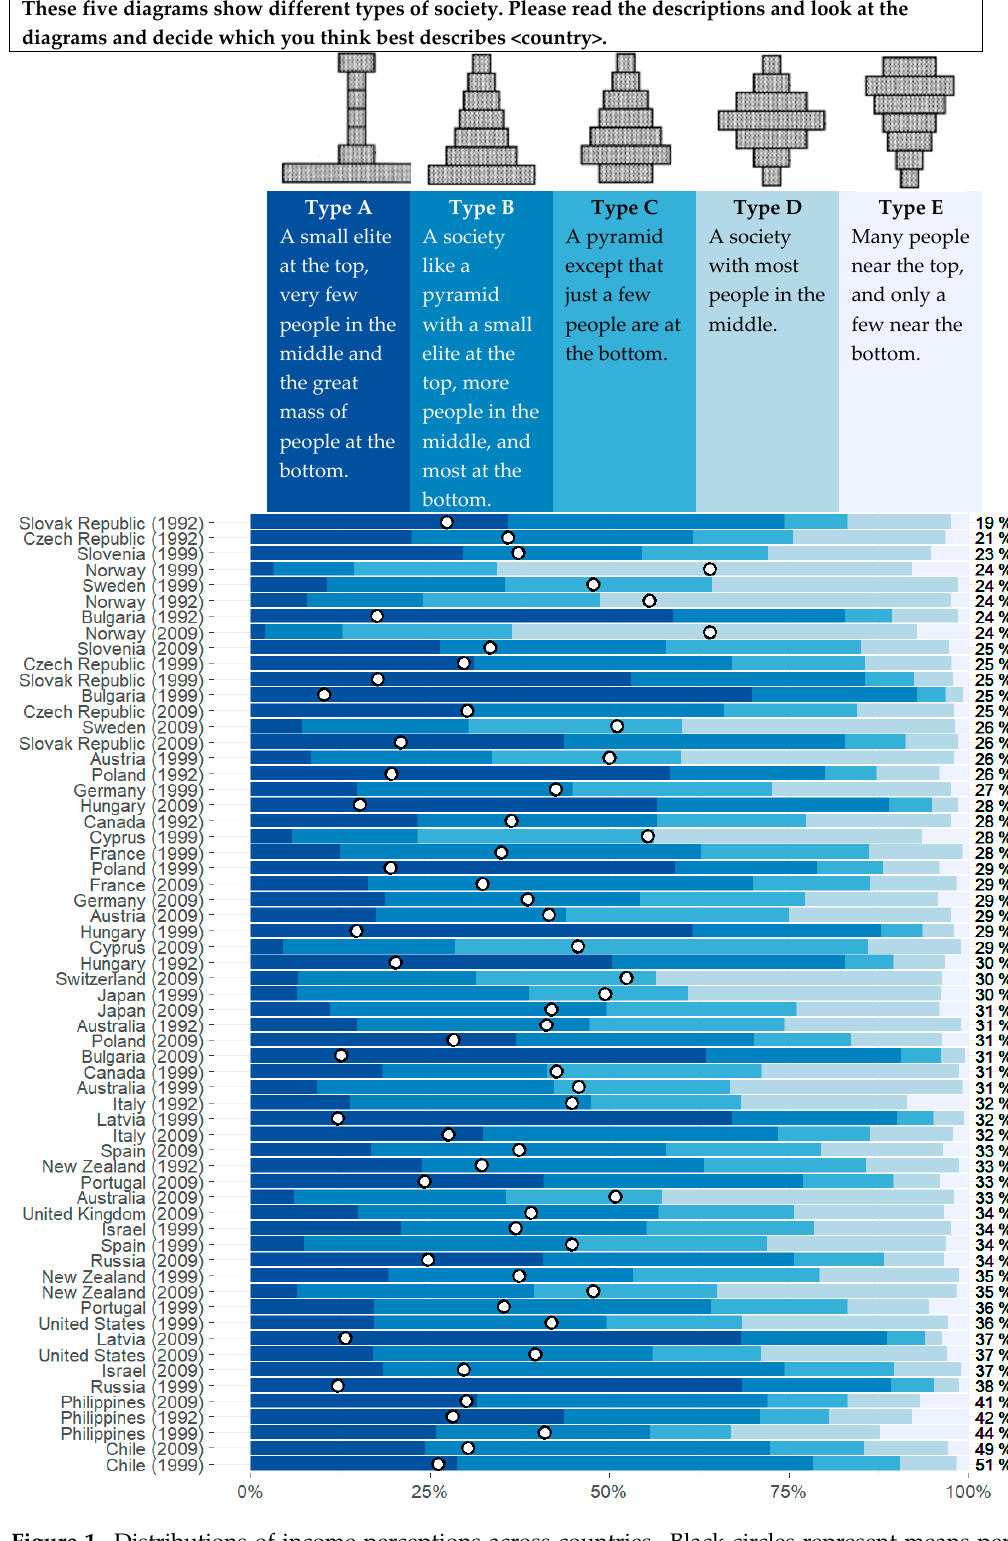
Figure 1. Distributions of income perceptions across countries. Black circles represent means per country-year. Country-years sorted by Gini net according to [21] expressed as a percentage shown in far right column. Note: Figure 1 is inspired by the presentation in [16], Data and question based on Q14 in ISSP 1992, 1999,